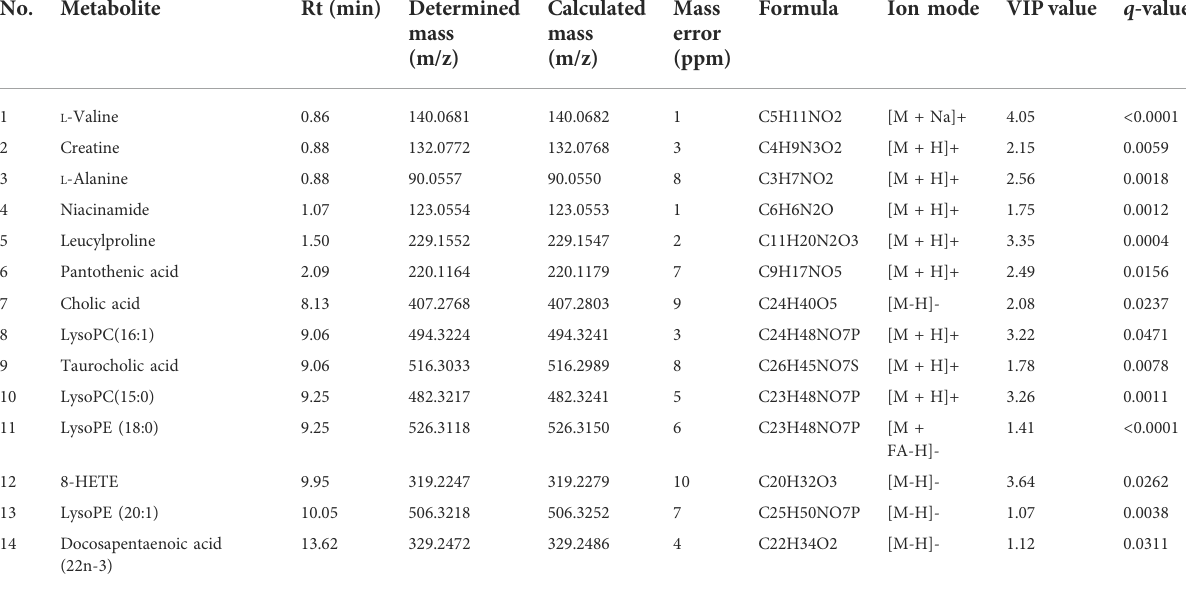
TABLE 1 Identi fi ed potential biomarkers of ulcerative